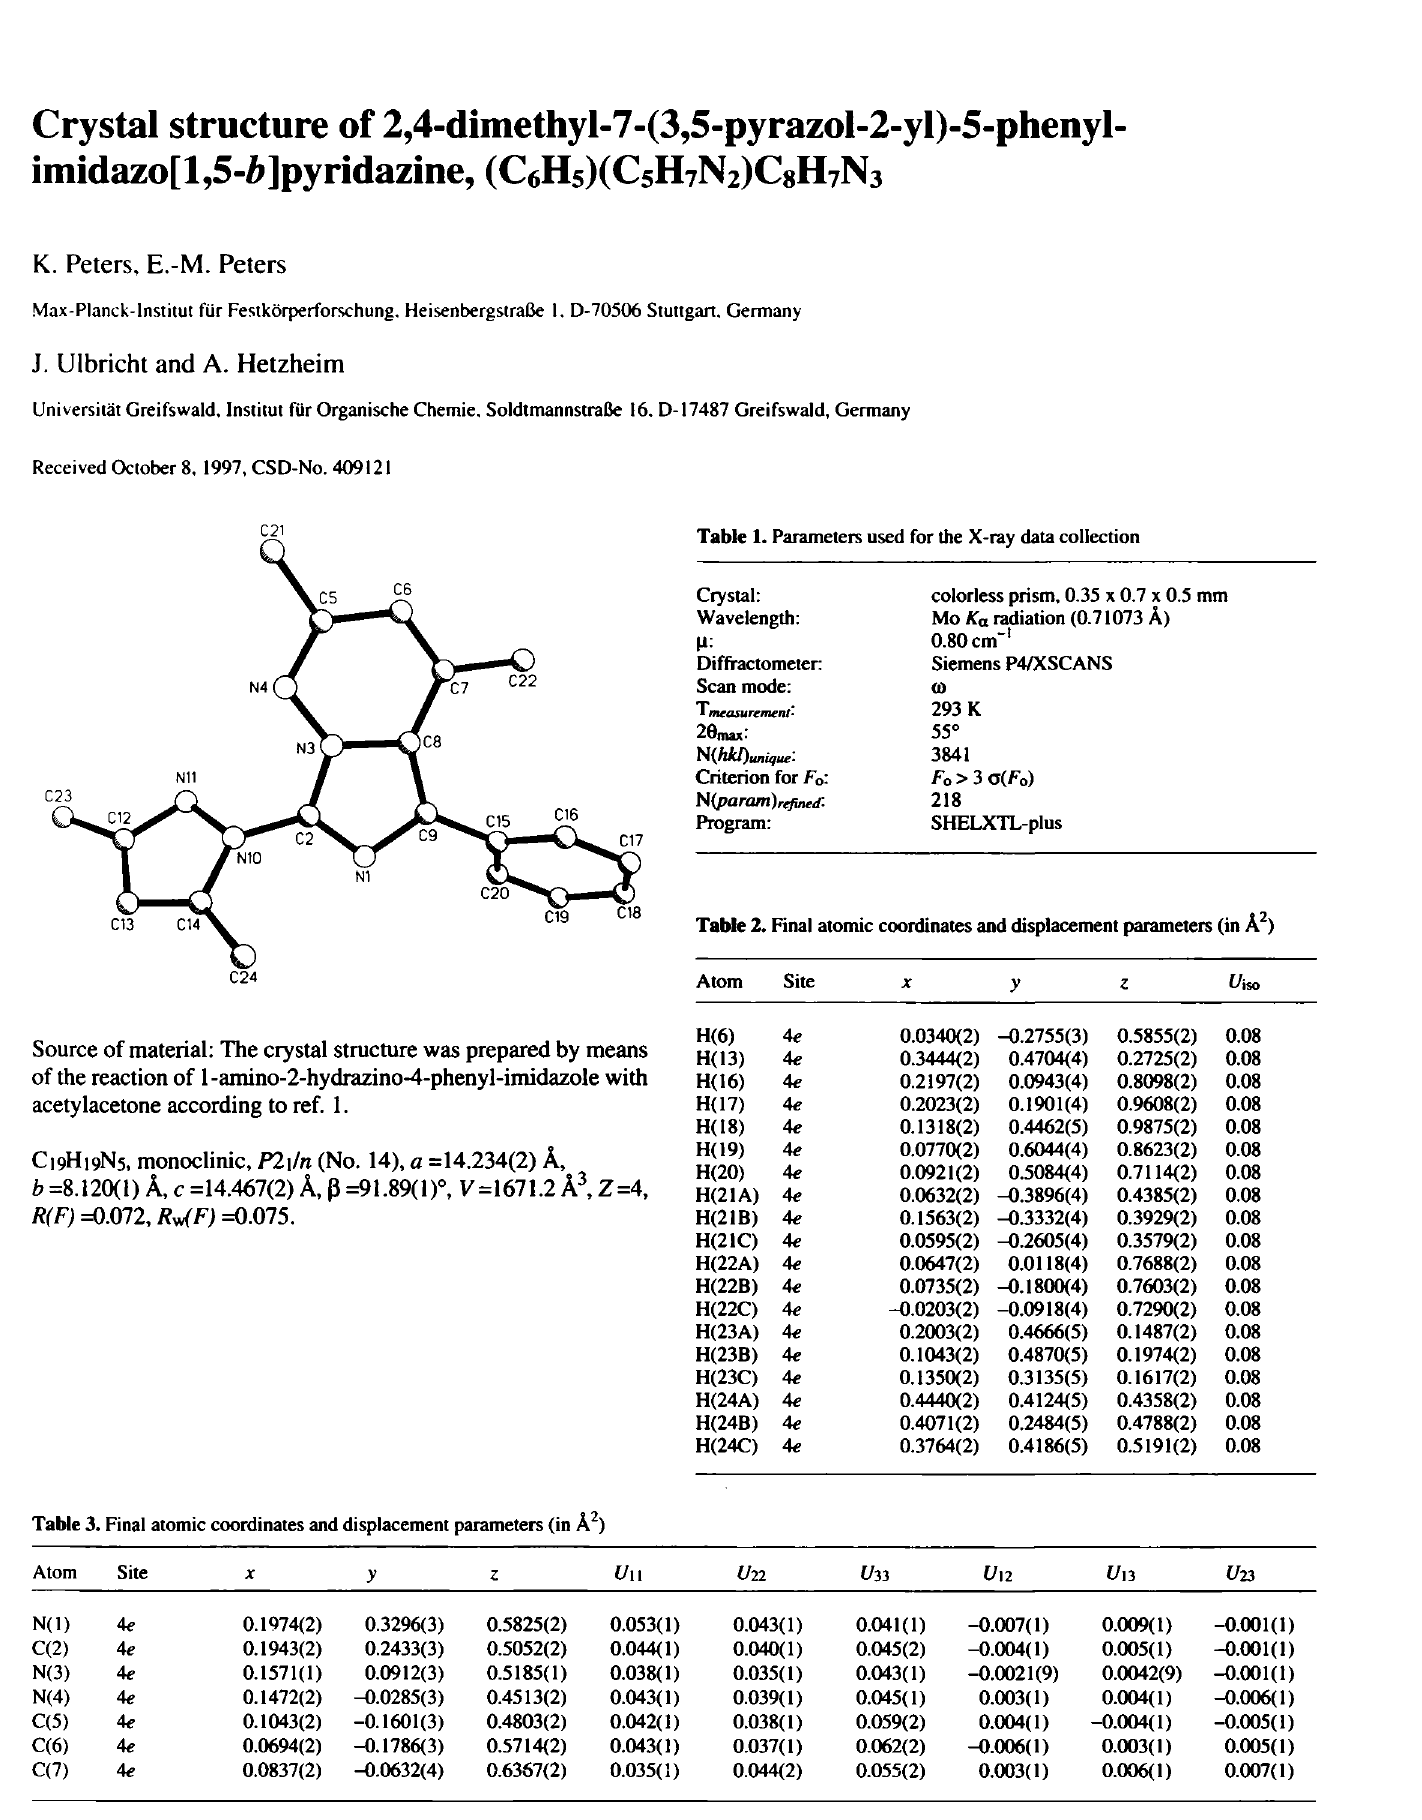
Table 1. Parameters used for the X-ray data collection